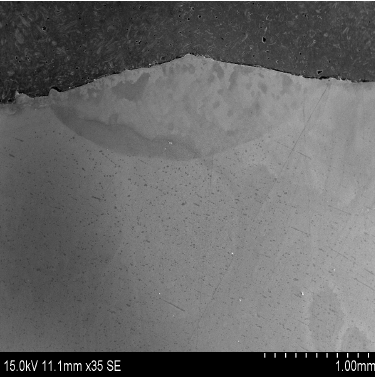
Figure 5. Macroscopic morphology in the cross section of coating.